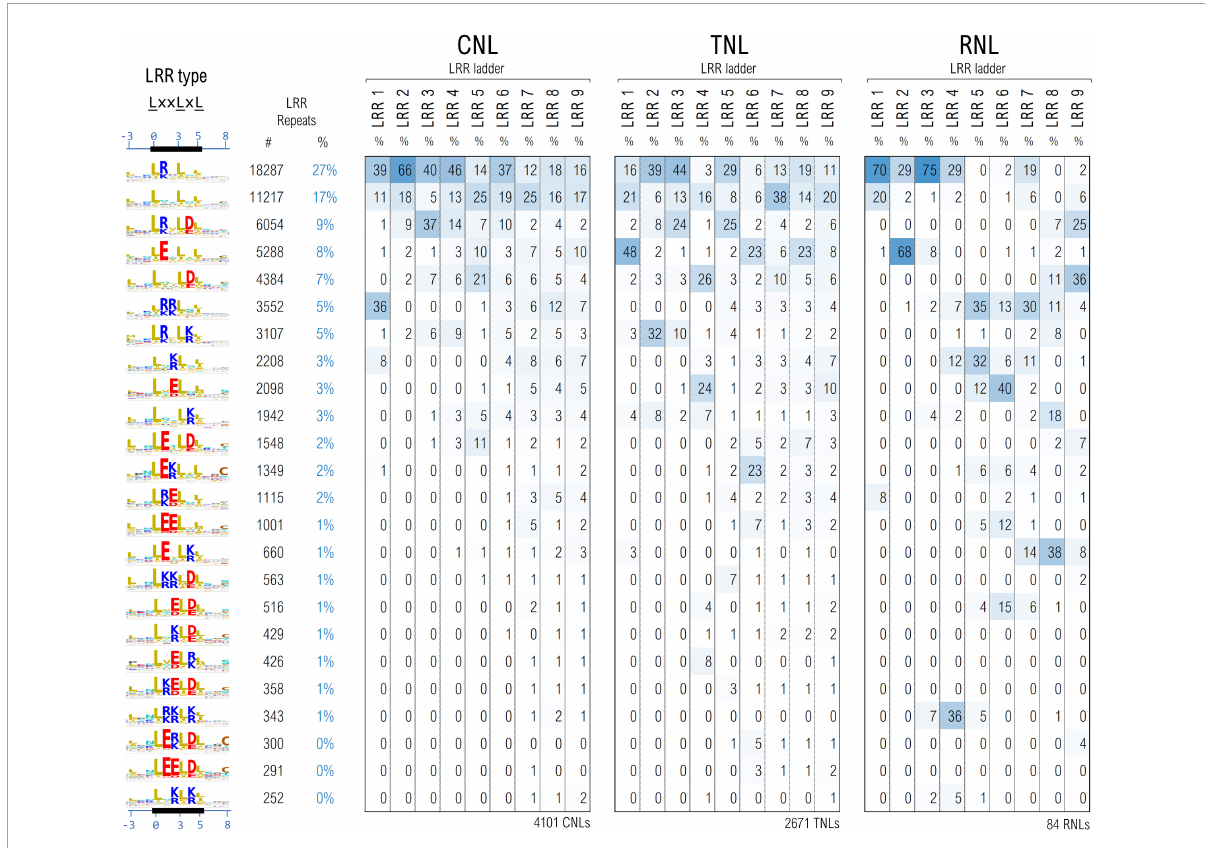
FIGURE6 Clustering of the LRR motifs in a physico-chemical properties embedding—top 24 clusters and their distribution among position in the LRR domain ladder in the three NLR classes. Displayed values are percentages normalized vertically, with respect to the total number of repeats in the given position of the ladder. Amino acids are colored as described in Figure 3